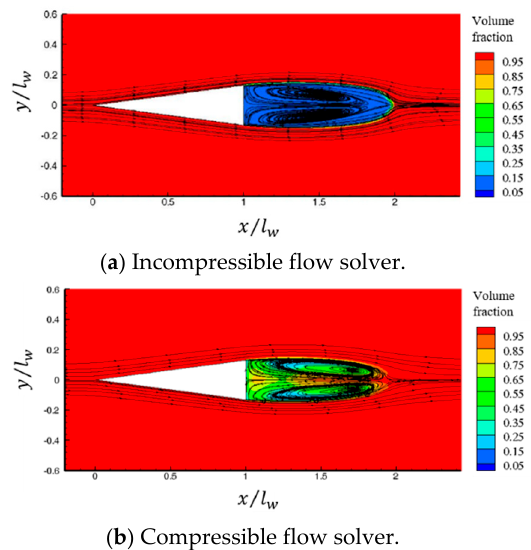
Figure 7. Volume fraction contours and streamlines around wedge at σ = 0.4.